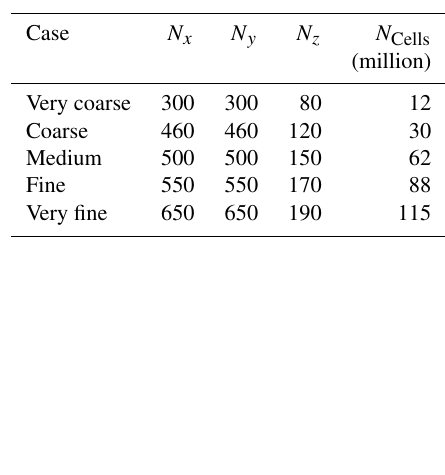
Table A1. Grid refinement study parameters showing the number of cells per main